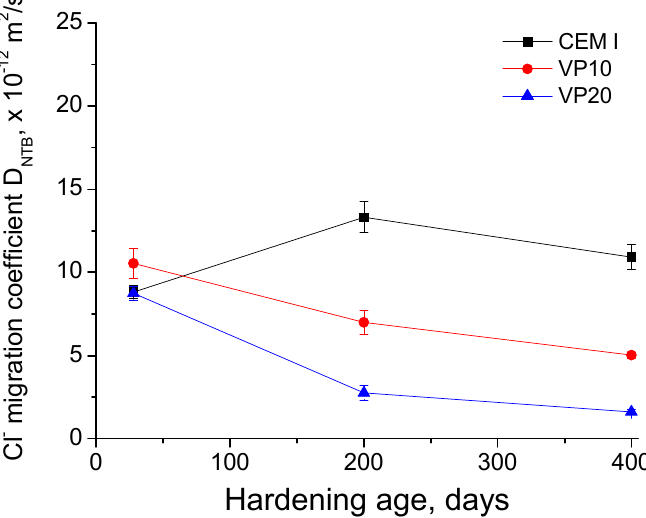
Figure 15. Results of the non-steady-state chloride migration coefficient for the mortars studied.